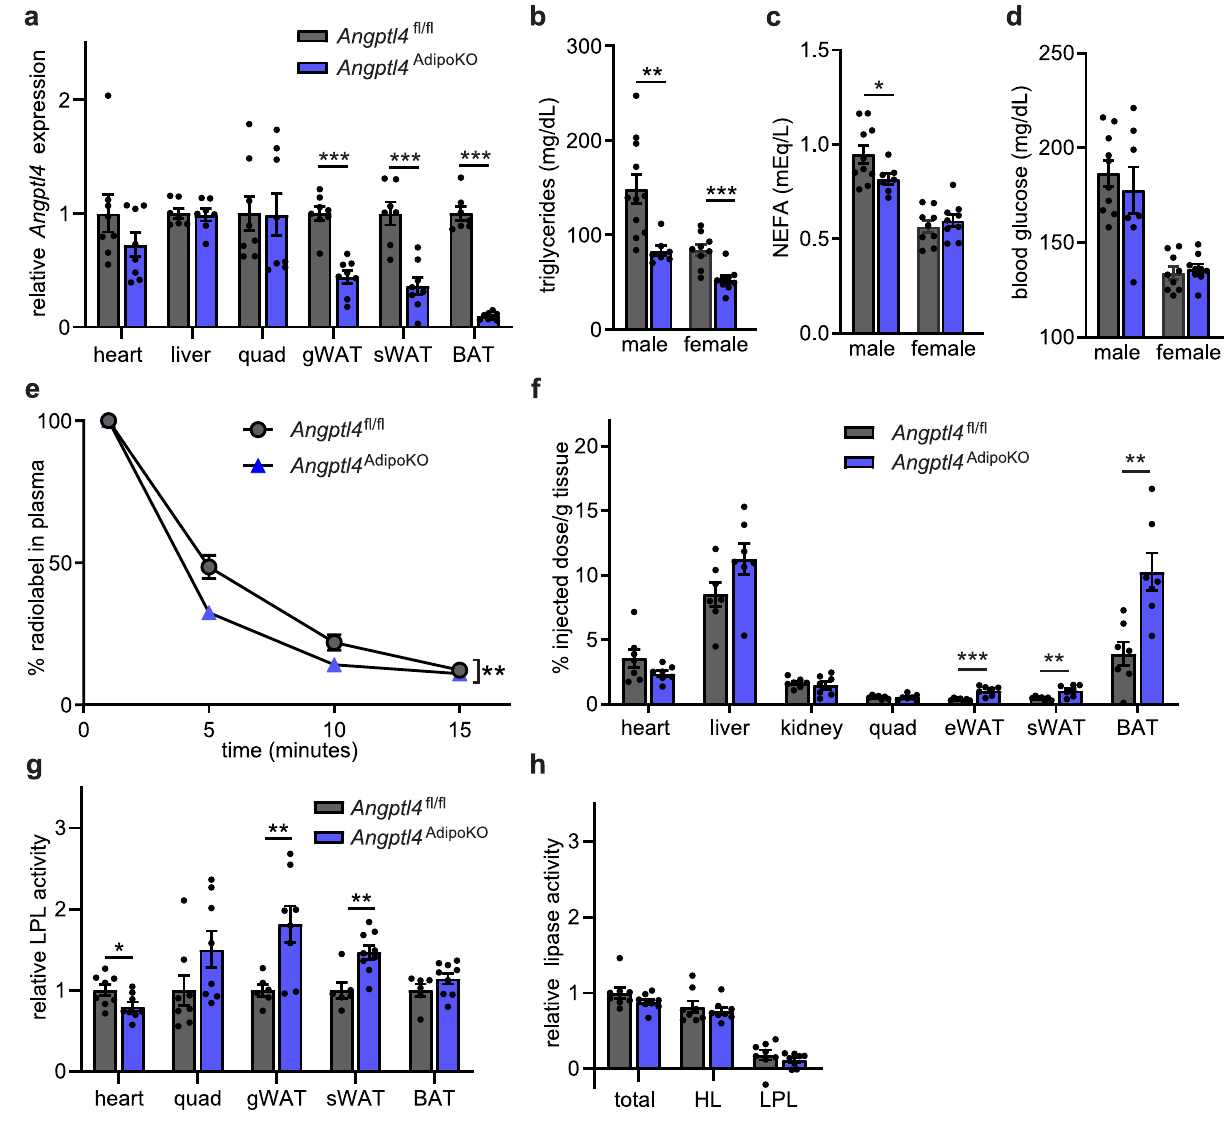
Figure 1. Characterization of mice with adipocyte-specific deletion of Angptl4 . ( a ) mRNA expression of Angptl4 in liver, heart, quadriceps muscle (quad), gonadal white adipose tissue (gWAT), subcutaneous white adipose tissue (sWAT), and brown adipose tissues (BAT) from 8–12 week old female Angptl4 fl/fl (n = 8) and Angptl4 AdipoKO (n = 8) mice following a 6 h fast (mean ± SEM). ( b – d ) Fasting plasma triglyceride ( b ), non- esterified fatty acid ( c ), and blood glucose ( d ) levels in 8–12 week male and female Angptl4 fl/fl and Angptl4 AdipoKO mice following a 6 h fast (mean ± SEM; n = 7–11). ( e , f ) Fasted (6 h) female Angptl4 fl/fl (n = 8) and Angptl4 AdipoKO (n = 7) mice were injected intravenously with 3 H-triglyceride–containing chylomicrons. ( e ) Clearance of radiolabel from the plasma 1, 5, 10, and 15 min after injection. Points represent percentage of radiolabel remaining in the plasma at the indicated time points compared to the 1 min time point (mean ± SEM). ( f ) Uptake of radiolabel after 15 min (% injected dose/g tissue) into the indicated tissues (mean ± SEM). ( g ) Heart, quadricep muscle (quad), gonadal white adipose tissue (gWAT), subcutaneous adipose tissue (sWAT), and brown adipose (BAT) tissue from fasted (6 h) female Angptl4 fl/fl and Angptl4 AdipoKO mice were harvested and lipase activity was measured (n = 6–9/group). ( h ) Liver was harvested from fasted (6 h) female Angptl4 fl/fl and Angptl4 AdipoKO mice (n = 8/group). Lipase activity was measured in the presence or absence of 1 M-NaCl to distinguish between hepatic and lipoprotein lipase. Bars show relative lipase activity in each tissue normalized to Angptl4 fl/fl (mean ± SEM). *p < 0.05, **p < 0.01, ***p < 0.001 by t-test analysis (panels a – c , f , g ) or repeated measures ANOVA (panel e